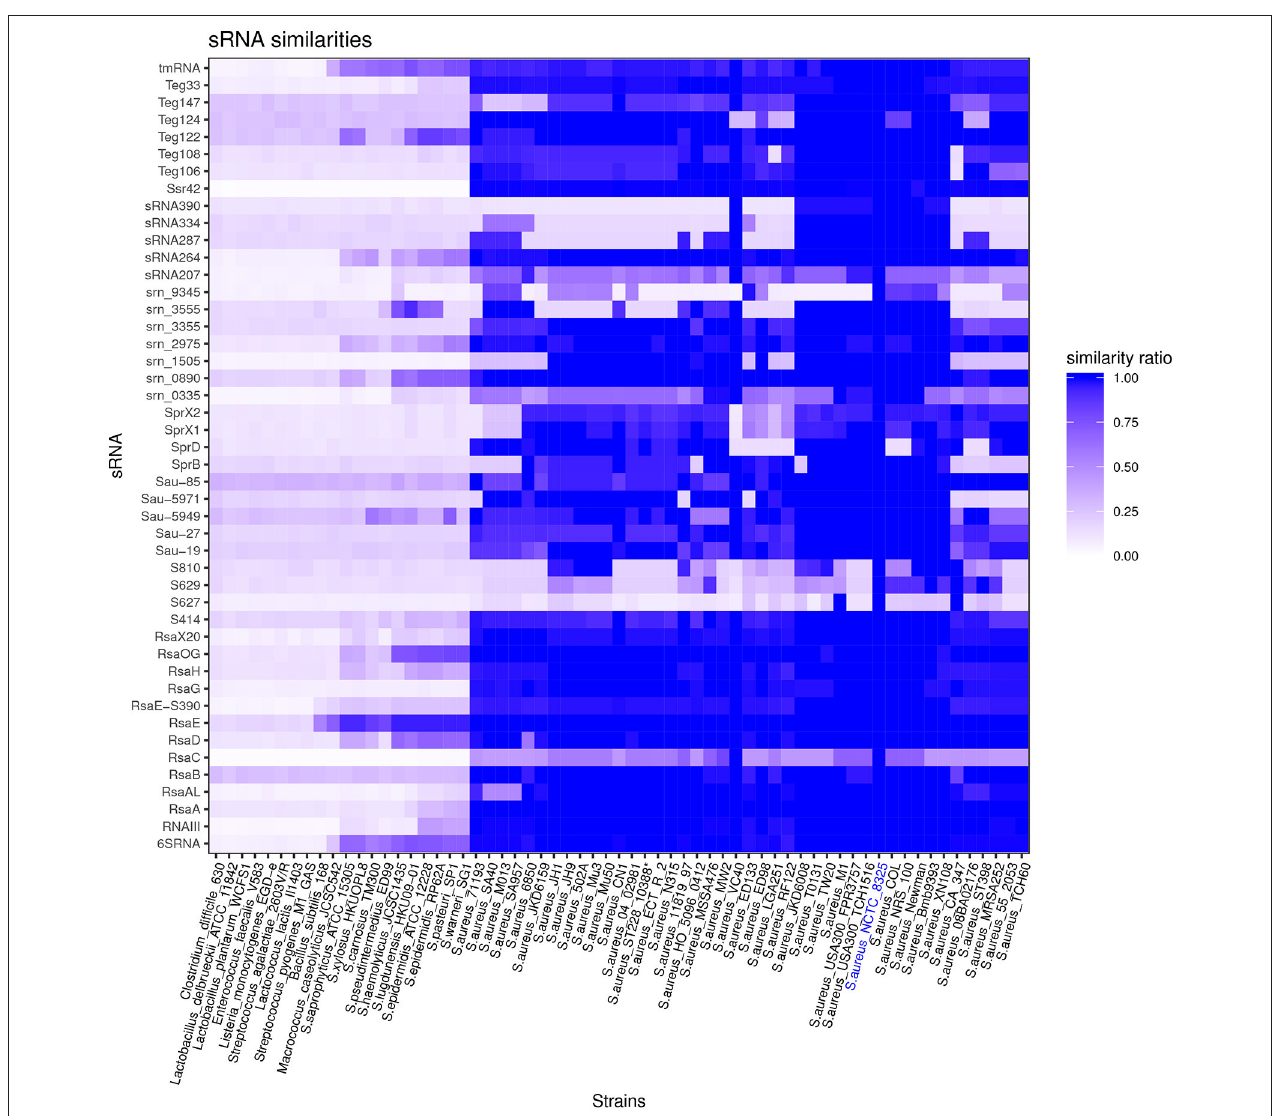
FIGURE 3 | Staphylococcus aureus sRNAs conservation across the Firmicutes phylum. Vertical axe: list of bona fide sRNAs. Horizontal axe: list of S. aureus strains and other Firmicutes (for accession numbers, see Table S2). Similarity ratios between sRNAs of indicated strains and NCTC8325 sRNAs (reference strain) are represented by the indicated color